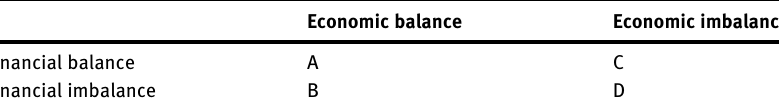
Table  : Matrix of fi nancial and economic